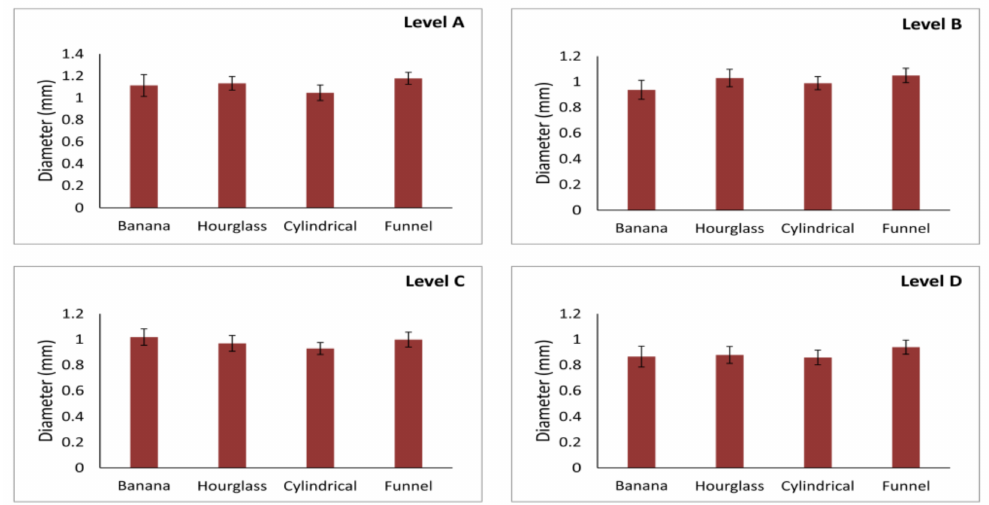
Figure 3. Maximal diameter of accessory canal at different levels of anterior maxilla according to NPC shape. Values are expressed as the mean ± SEM.